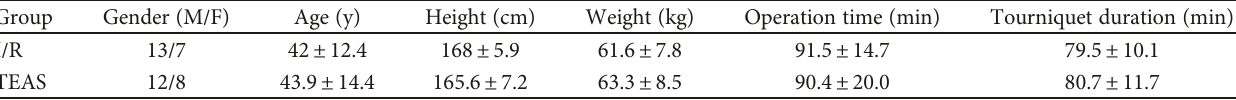
Table 1: Clinical characteristics of the patients ( n = 20 in each group). Data are expressed as mean ± standard deviation. Group Gender